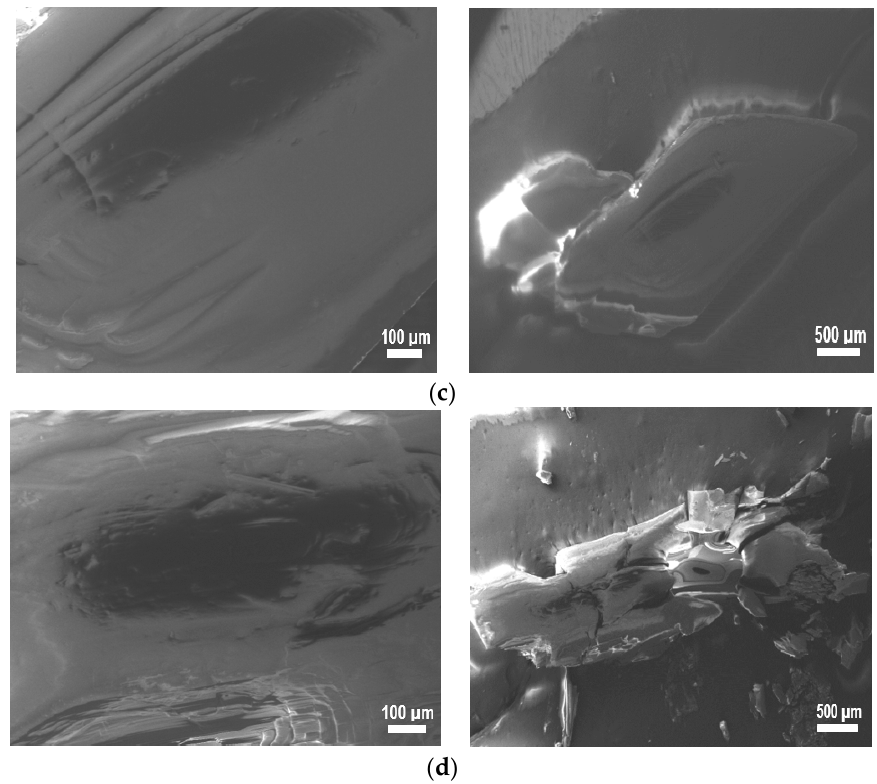
Figure 5. SEM images of ( a ) I , ( b ) I − F , ( c ) I − Cl , and ( d ) I − Br samples.